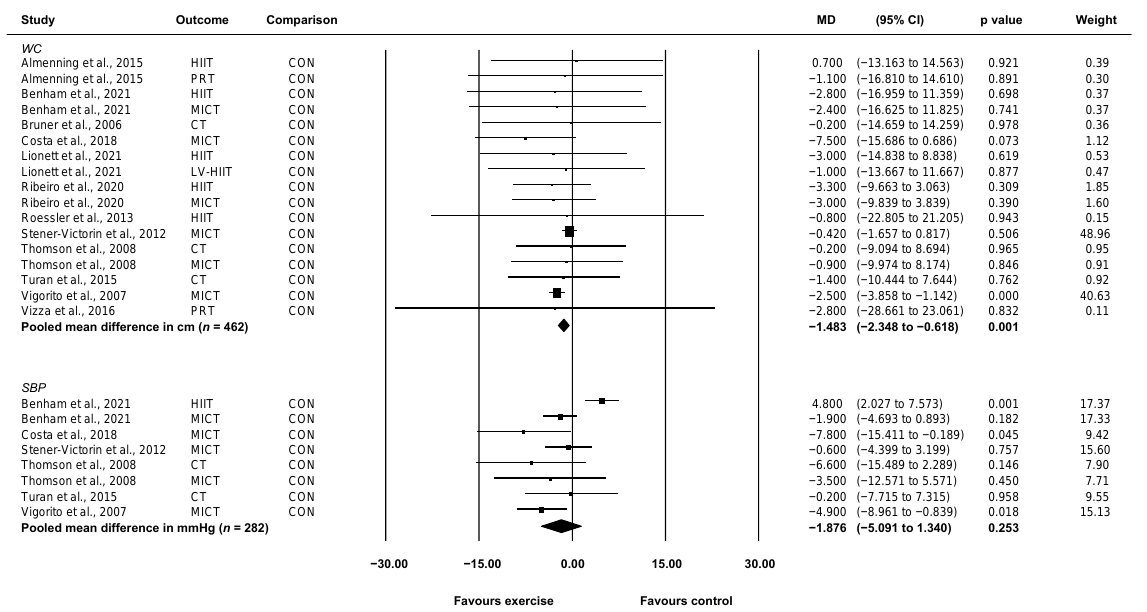
following Egger’s test.